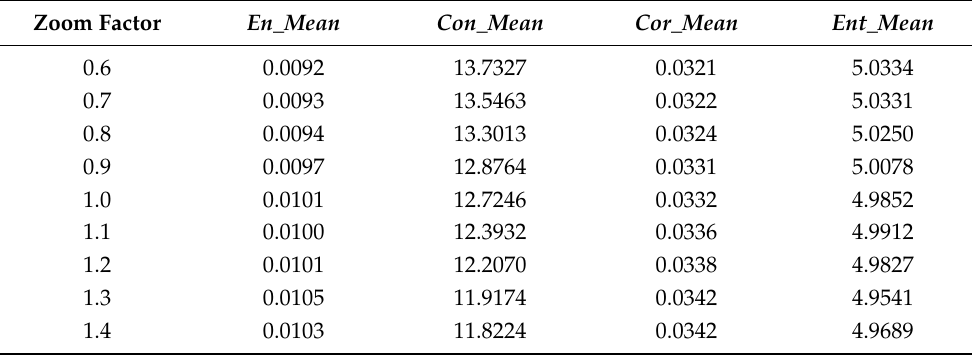
Table 10. Results of traditional GLCM with different zoom